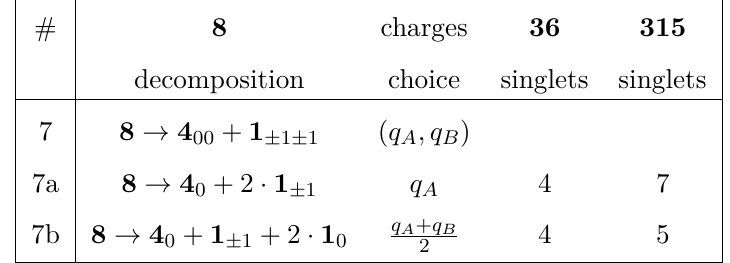
Table 1 . Branchings for the case 7.